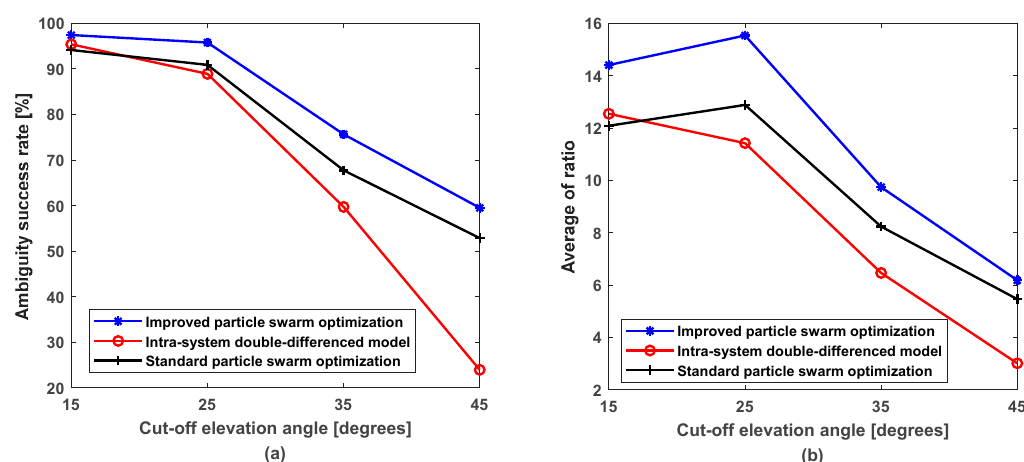
Figure 6. Ambiguity success rate and average of ratio at different cut-off elevation angles. ( a ) Ambiguity success rate. ( b ) Average of ratio.